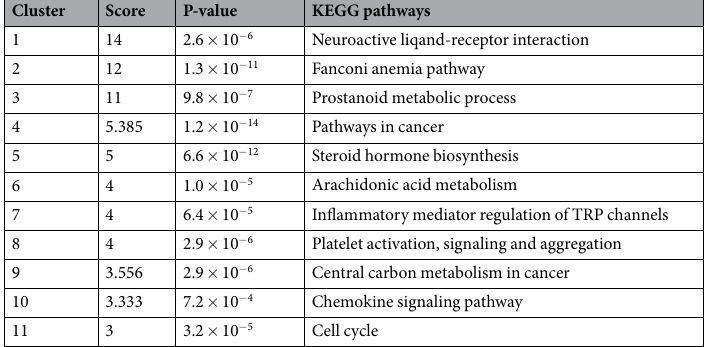
Table 1. The main biological process of the modules.